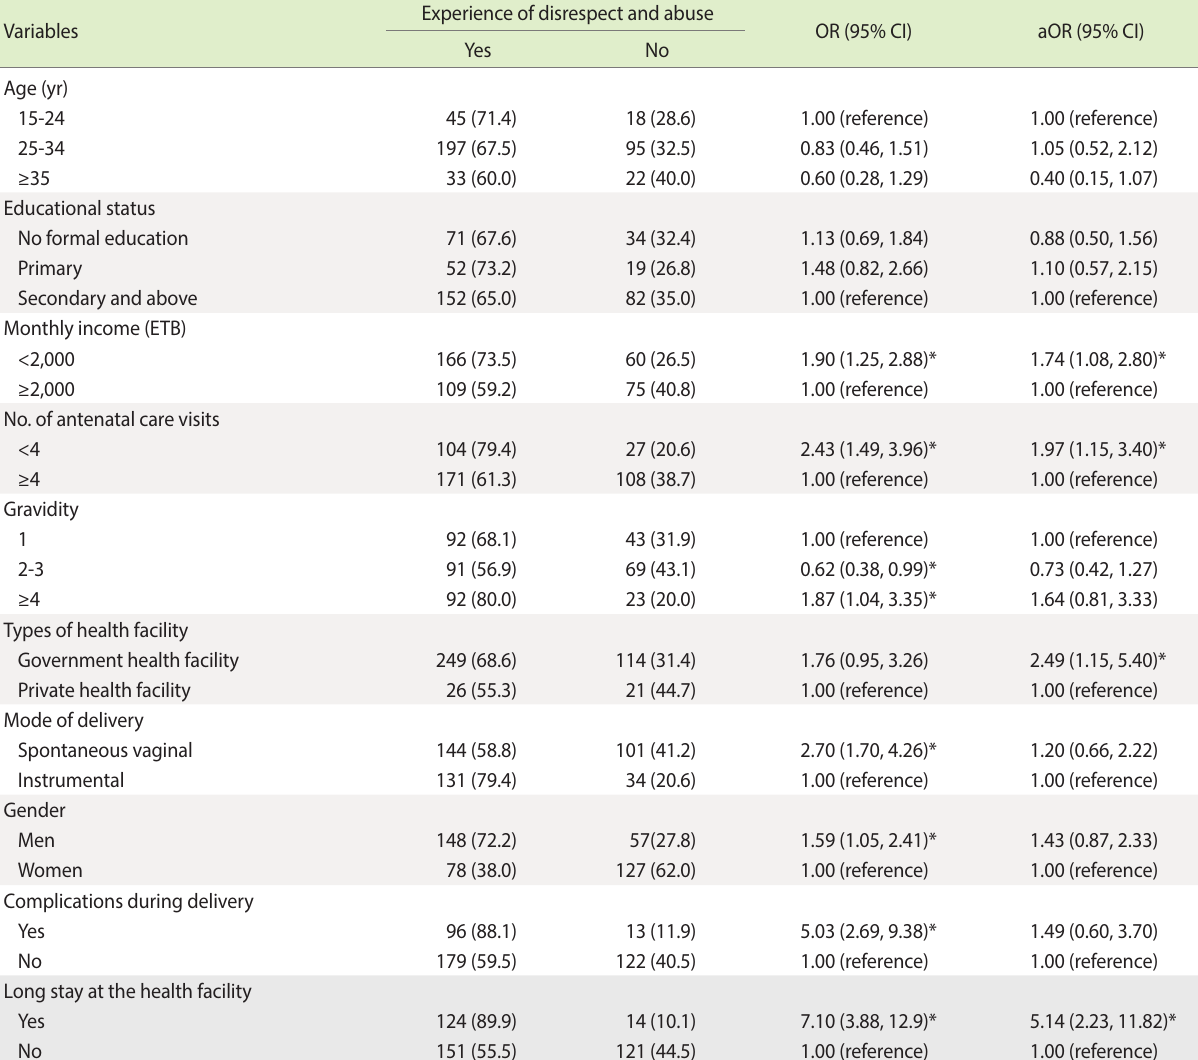
Table 4. Factors associated with disrespect and abuse during labor and delivery among mother in the town of Bahir Dar, northwest